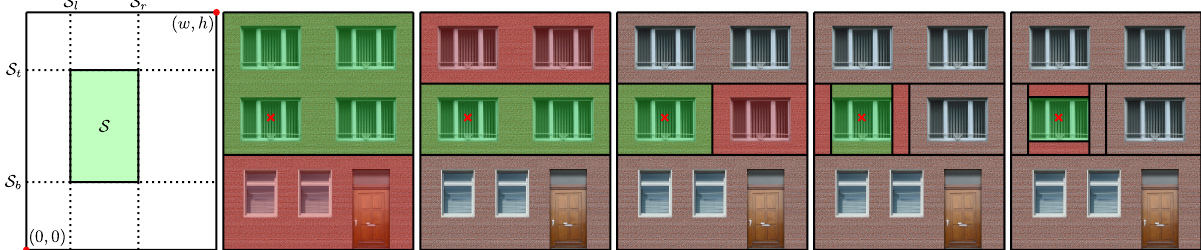
Figure 2: Taking the size of the whole facade as the start scope S = (0 , 0 , w, h ) , we recursively check for each operator of the grammar to which element a certain pixel of the final image belongs (shown in green). This will iteratively update the scope S = ( S l , S b , S r , S t ) until we hit a terminal symbol that samples a